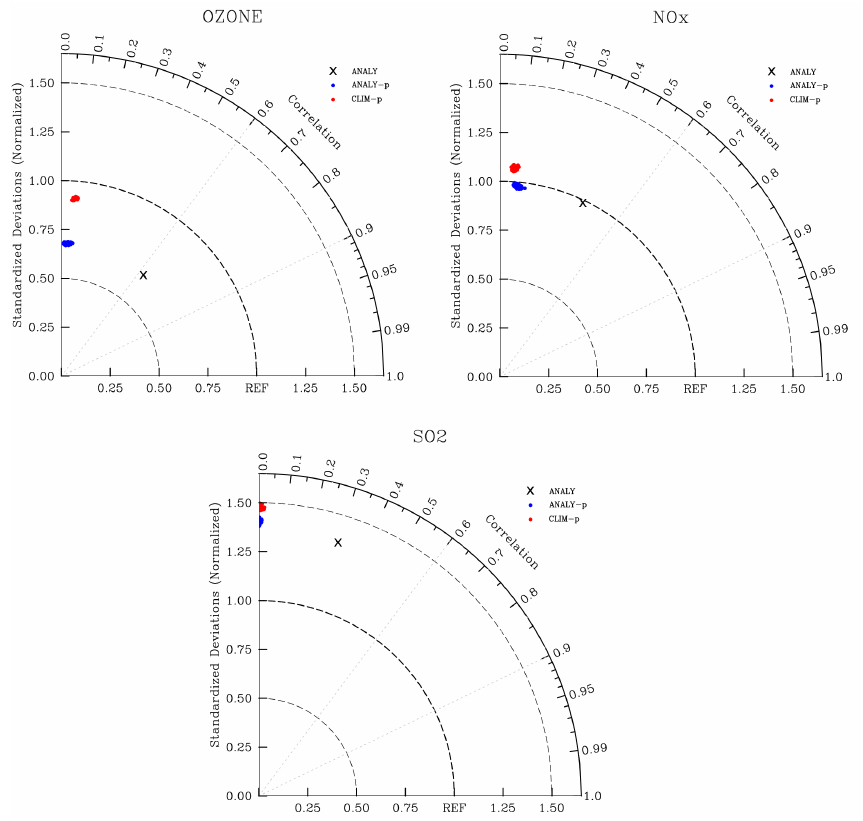
Fig. 13. Taylor plots of the comparison between modeled and observed M × 8h O 3 concentrations, daily mean NO x and daily mean SO 2 . The radial distance from the origin corresponds to NSD, and R corresponds to the azimuthal position. 51 Table 10. Seasonal JJAS statistics obtained with the permutations ANALY-p and CLIM-p. Statistics are the median values of the per- mutations. The calculated statistics are mean bias (µg m − 3 ), mean normalized bias (%), correlation coefficient, root mean square error (µg m − 3 ) and sigma ratio. Statistics are computed for the O 3 hourly value and daily M × 8h